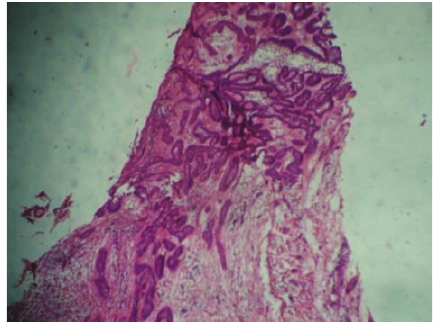
Figure 4: Cystic lumen lined by nonkeratinized stratified squamous epithelium showing prominent basal cells (H and E) 10x.